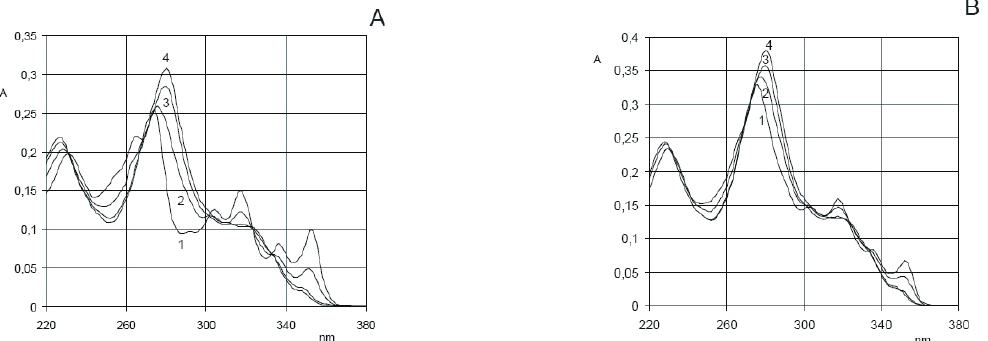
Figure 1. Absorption spectra of dihydrochelerythrine (c methanol (A) and in 60% ethanol (B): A: 1 – pH = 2,10; 2 – pH = 3,11; 3 – pH = 4,05; 4 – pH = 8,97; B: 1 – pH = 2,08; 2 – pH =